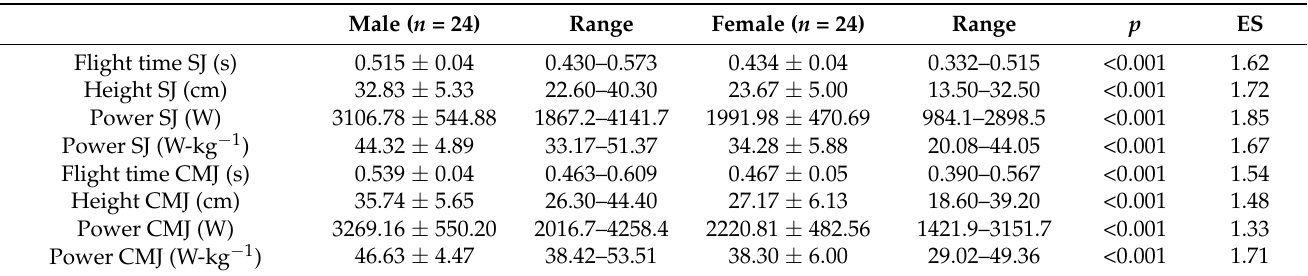
Table 4. Vertical jump test results.